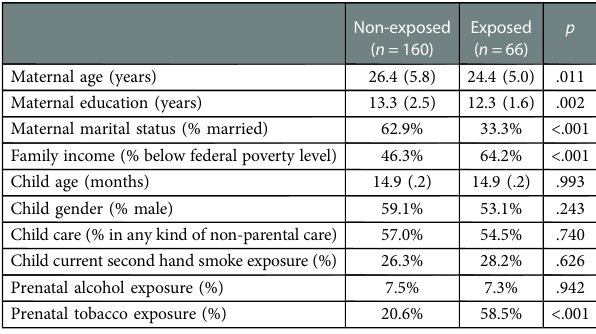
TABLE 1 Participant characteristics by in utero marijuana